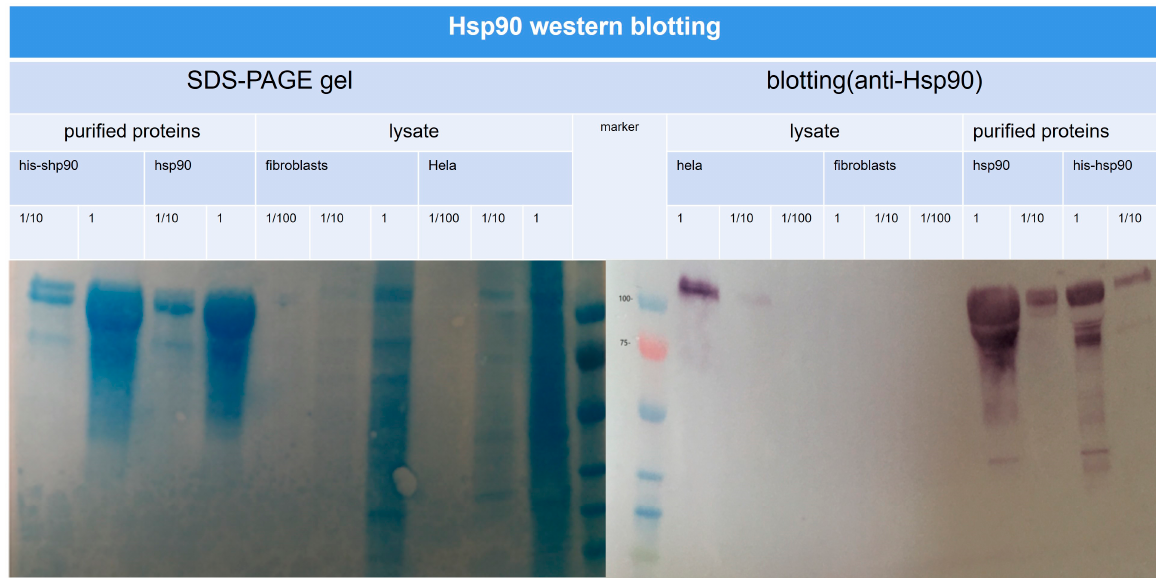
Figure 9. SDS PAGE shows HSP90 α is the predominantly expressed protein in HeLa cell lysate compared to other proteins. Western blot confirms the presence of HSP90 α in HeLa cell lysate, 10× and 100× dilution around 100 Kd. Negative control fibroblast lysate as negative control has no HSP90 α , and positive control is purified HSP90 α in stock concentration (30 µg) and 1:10 dilution presents a dose-dependent manner of Hsp90 expression.